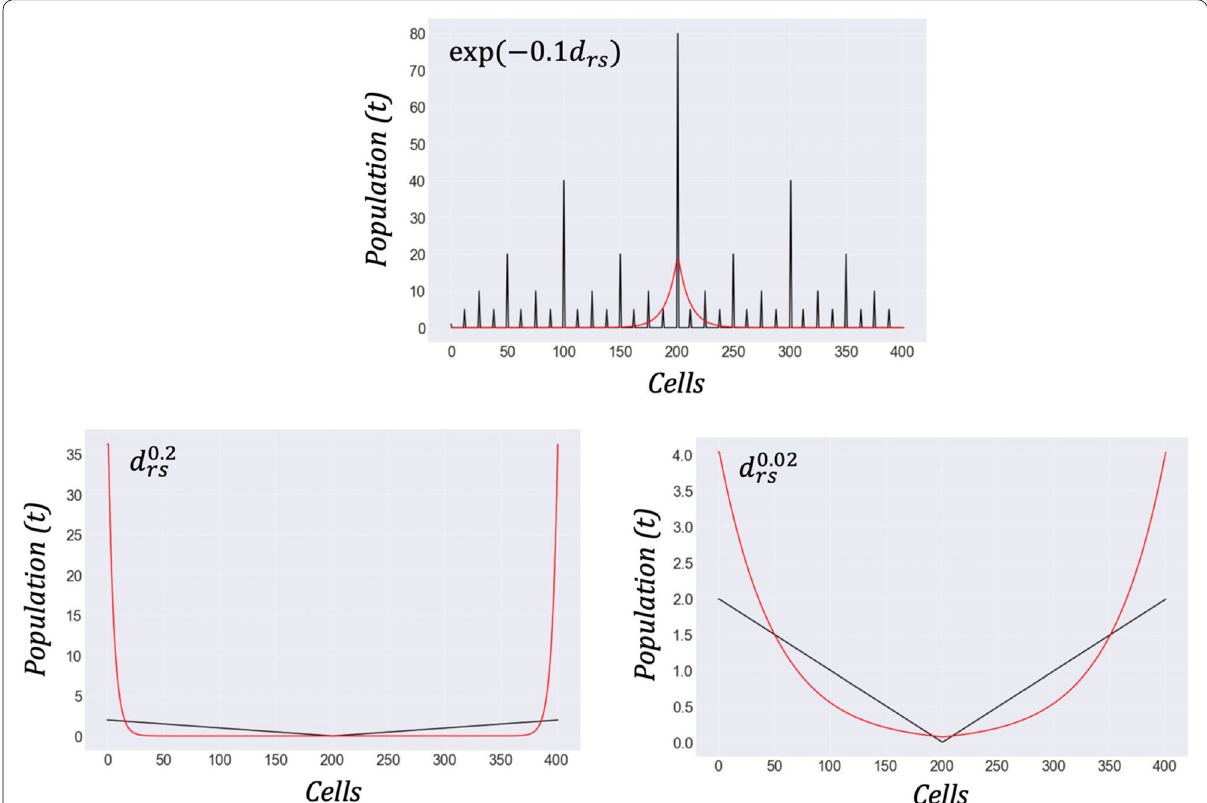
Fig. 6 Multiple Centres and Edge City Effects. The black lines show the distribution of population as arranged in a hierarchy in 6(a) and as edge effects in 6(b) and 6(c). The red lines show what the ultimate outcomes for each of these three cases as the system moves towards